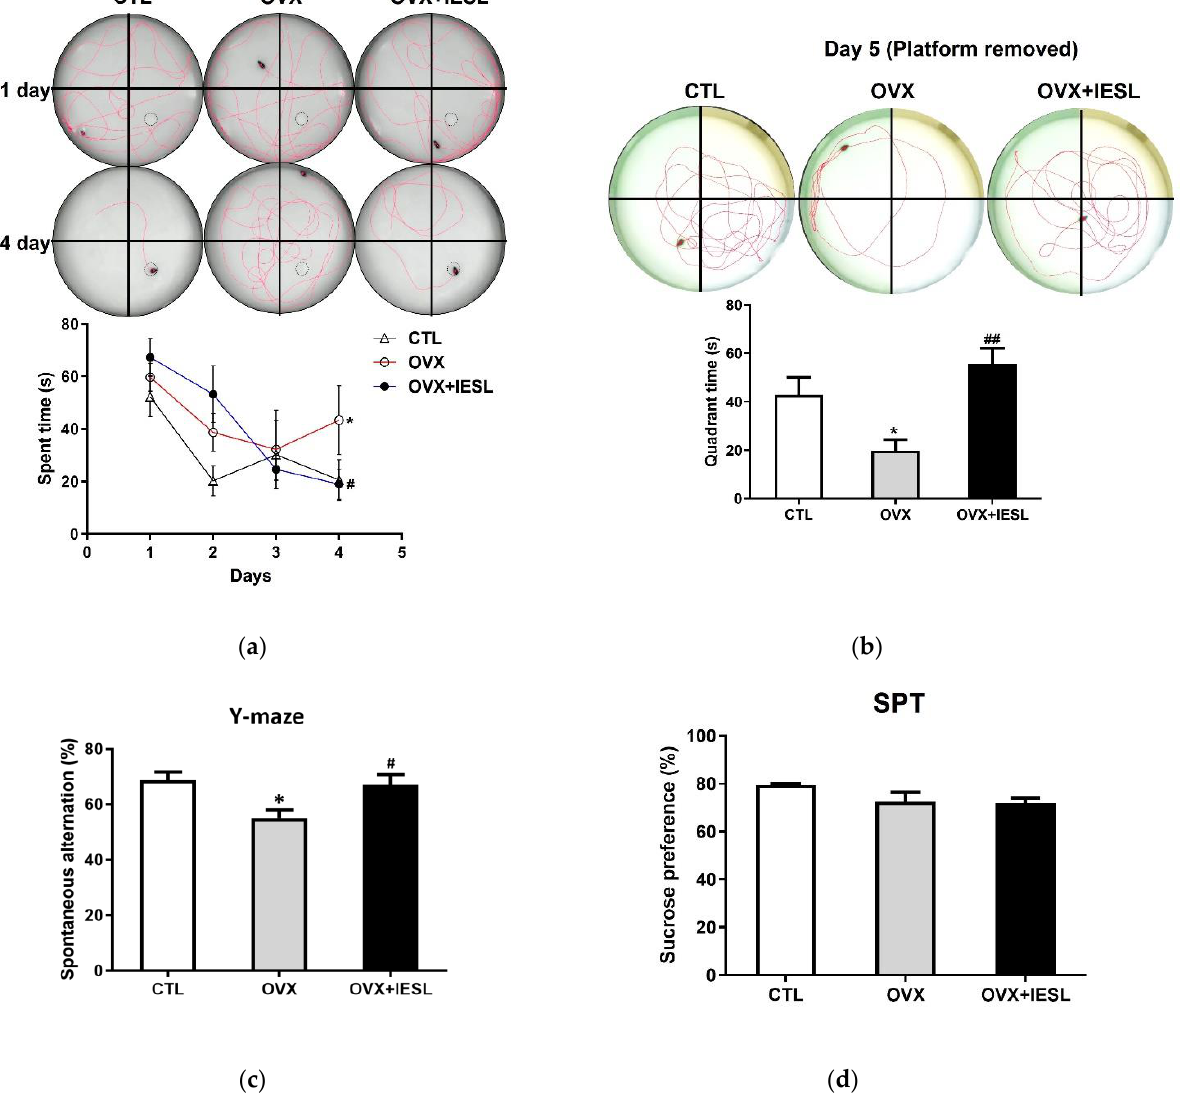
Figure 3. Effects of the IESL extracts on behavioral changes in the Morris water maze ( a , b ), Y-maze ( c ), and sucrose preference ( d ) tests. Representative individual swim paths and escape latency during four acquisition days ( a ), and representative individual swim paths and comparison of time spent in the target quadrant after removing the platform on day 5 ( b ). Spontaneous alternation (%) in the Y-maze test ( c ) and the sucrose preference test (SPT) in the CTL, OVX, and OVX+IESL groups ( d ). Data are expressed as the mean ± S.E.M. * p < 0.05 vs. the CTL group; # p < 0.05 and ## p < 0.01 vs. the OVX group.